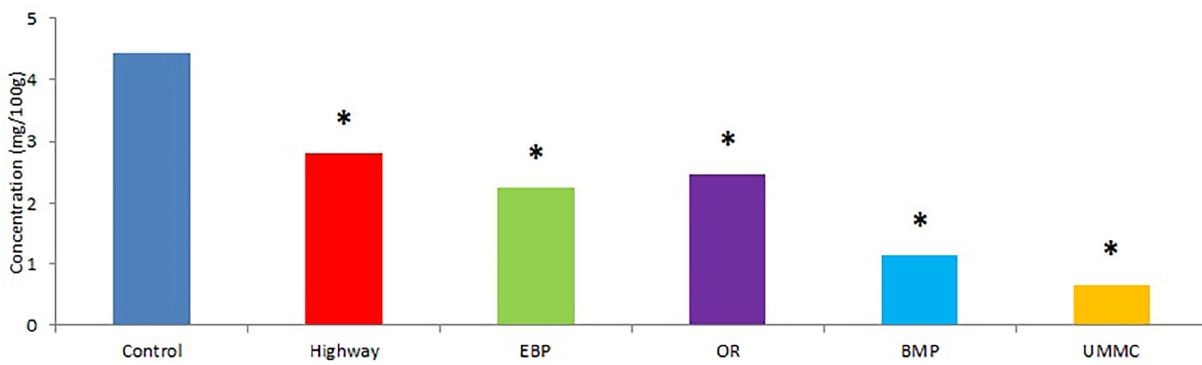
Figure 8. Flavonoids’ concentrations in coltsfoot from studied areas. *—statistically significant difference between control and test group ( p ≤ 0.05).